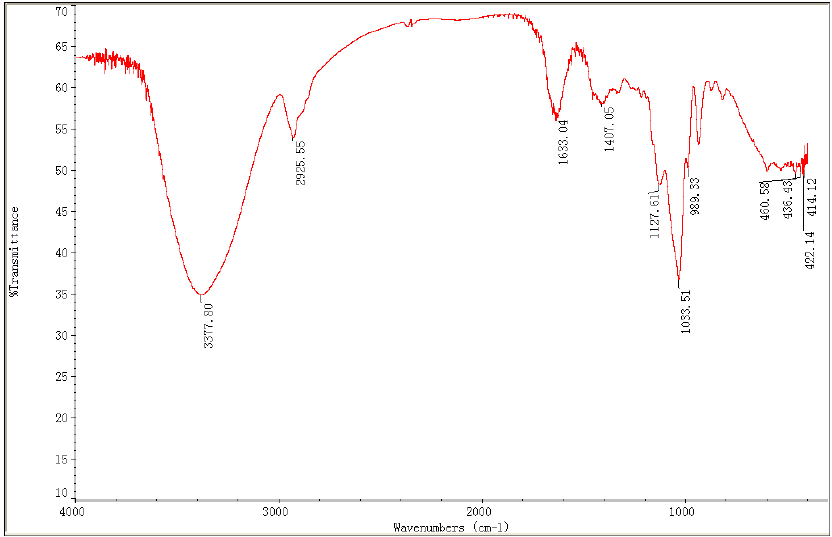
Figure 5. The FT-IR spectrum of RAMP.